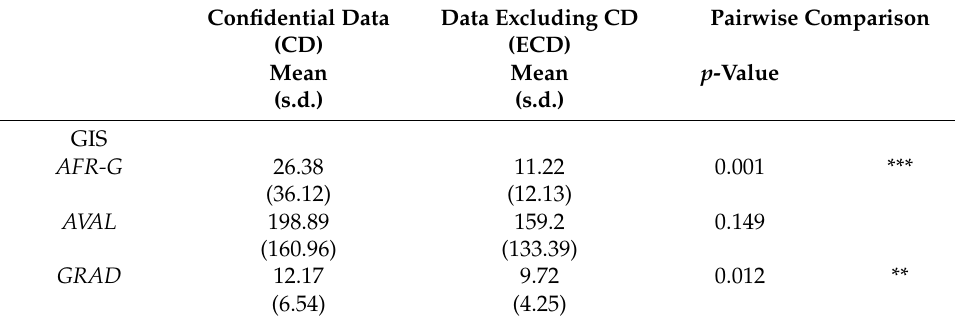
Table A1. Descriptive statistics of confidential data and